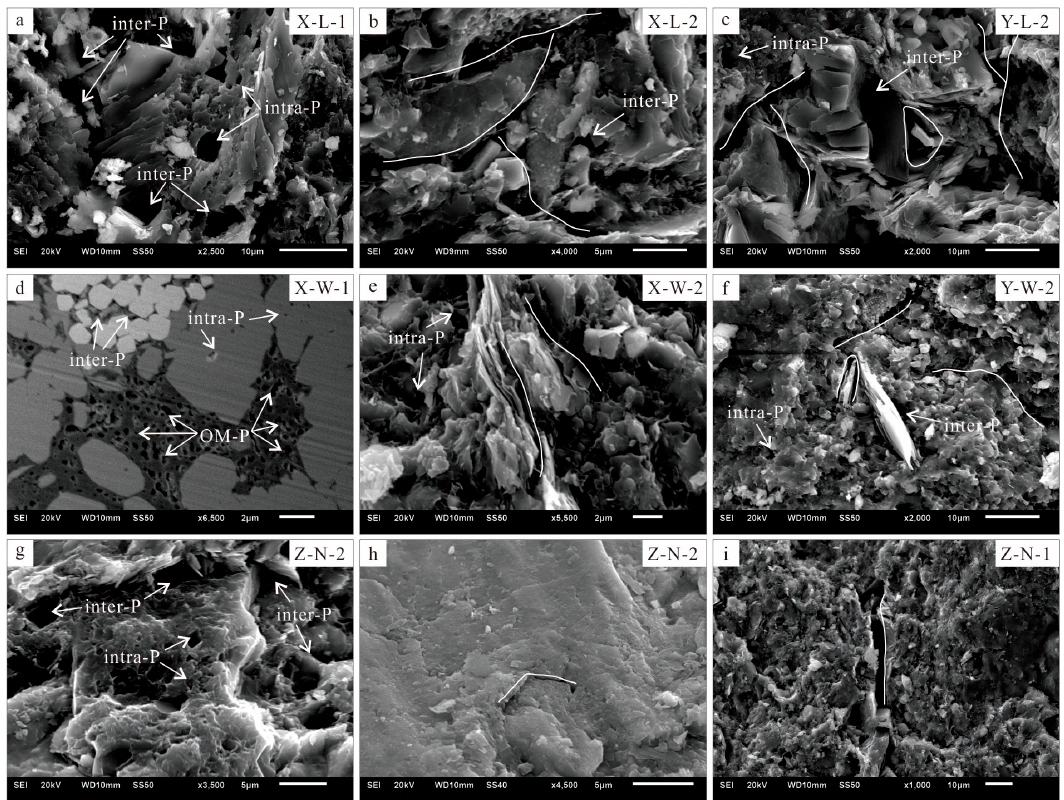
Figure 6. Images of pores and fractures from the collected shale samples using SEM inter-P (inter-particle pores), intra-P (intra-particle pores), OM-P (organic matter pores): ( a – c ) pores and fractures in LSL shale; ( d – f ) pores and fractures in UOW shale; ( g – i ) pores and fractures in LCN shale.